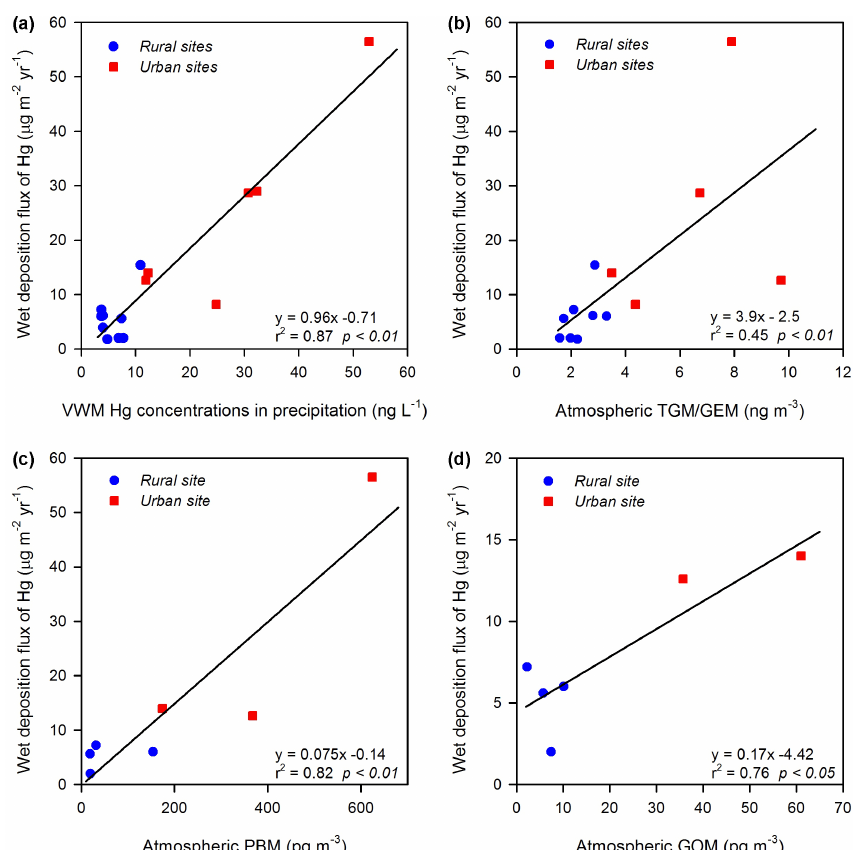
Figure 6. Correlations between wet deposition fluxes of Hg and (a) volume-weighted mean (VWM) Hg concentrations in precipitation, (b) atmospheric total gaseous mercury (TGM)/gaseous elemental mercury (GEM) concentrations, (c) atmospheric particulate bound mercury (PBM) concentrations, and (d) atmospheric gaseous oxidized mercury (GOM) concentrations in China. Data are from this study and the literature (Wang, 2006; Fu et al., 2011, 2015b; Huang et al., 2012; Wang et al., 2012; Zhu et al., 2012, 2014; Huang et al., 2013; Xu et al., 2014,